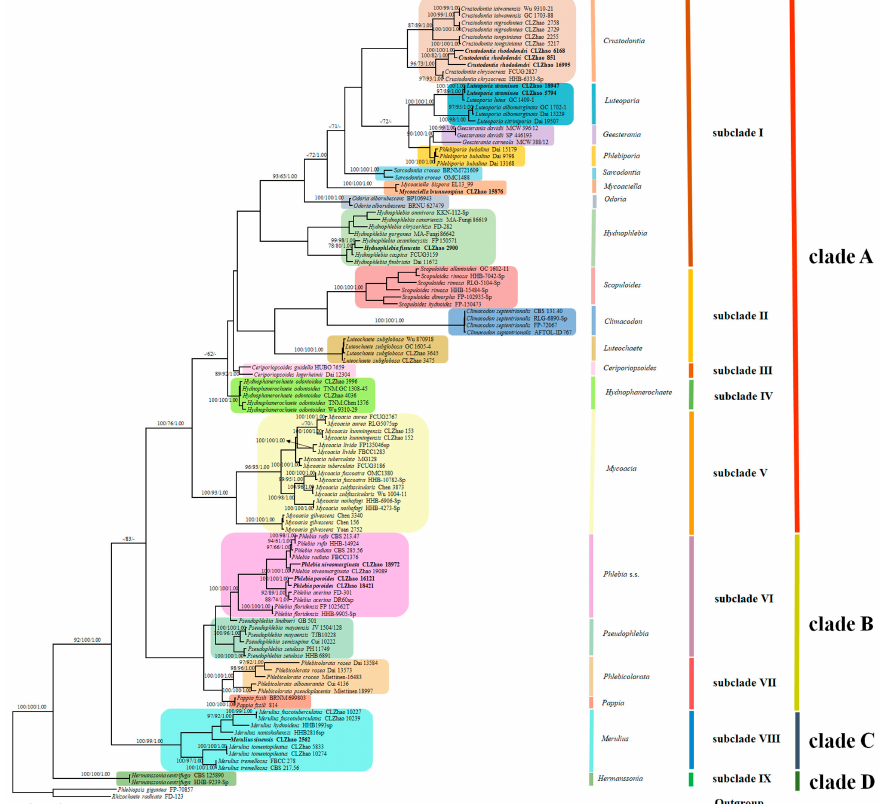
Figure 2. Maximum Parsimony strict consensus tree illustrating the phylogeny of Phlebia in the family Meruliaceae based on ITS + nLSU + TEF1 + mt-SSU + GAPDH + RPB1 + RPB2 sequences. Branches are labeled with (BS) > 70%, (BT) > 50% and (BPP) > 0.95, respectively. The new species are in bold.